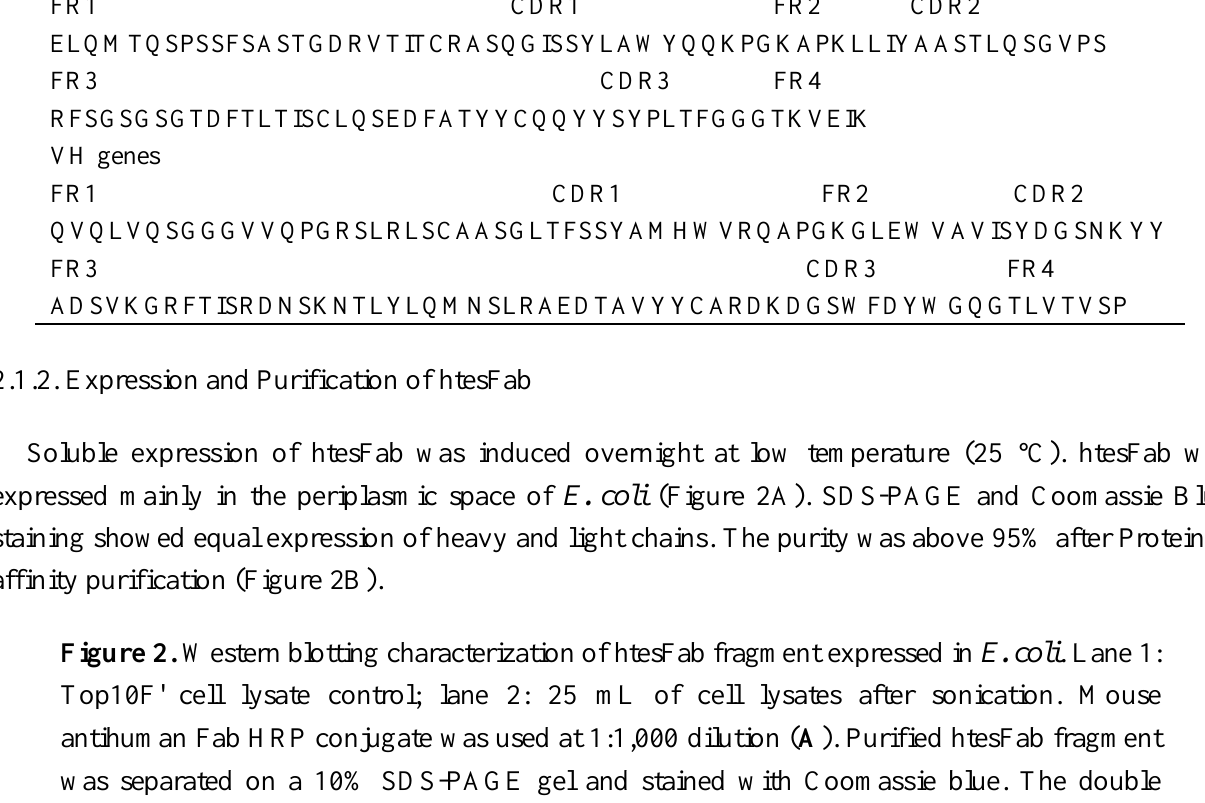
Figure 2. Western blotting characterization of htesFab fragment expressed in E. coli . Lane